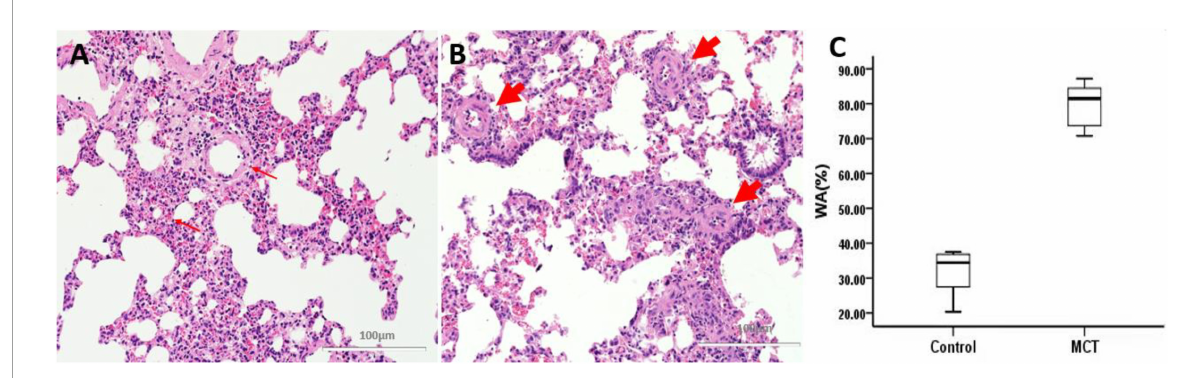
FIGURE4 Pulmonary muscular arterioles remodeling and stenosis. (A) Control group, normal rat pulmonary arterioles ( fine arrow ); (B) MCT group, pulmonary arteriole remodeling ( thick arrow ). Bar = 100 µ m. (C) The percentage of wall area to the total area of vessels (WA%). The thick arrow shows the muscular pulmonary